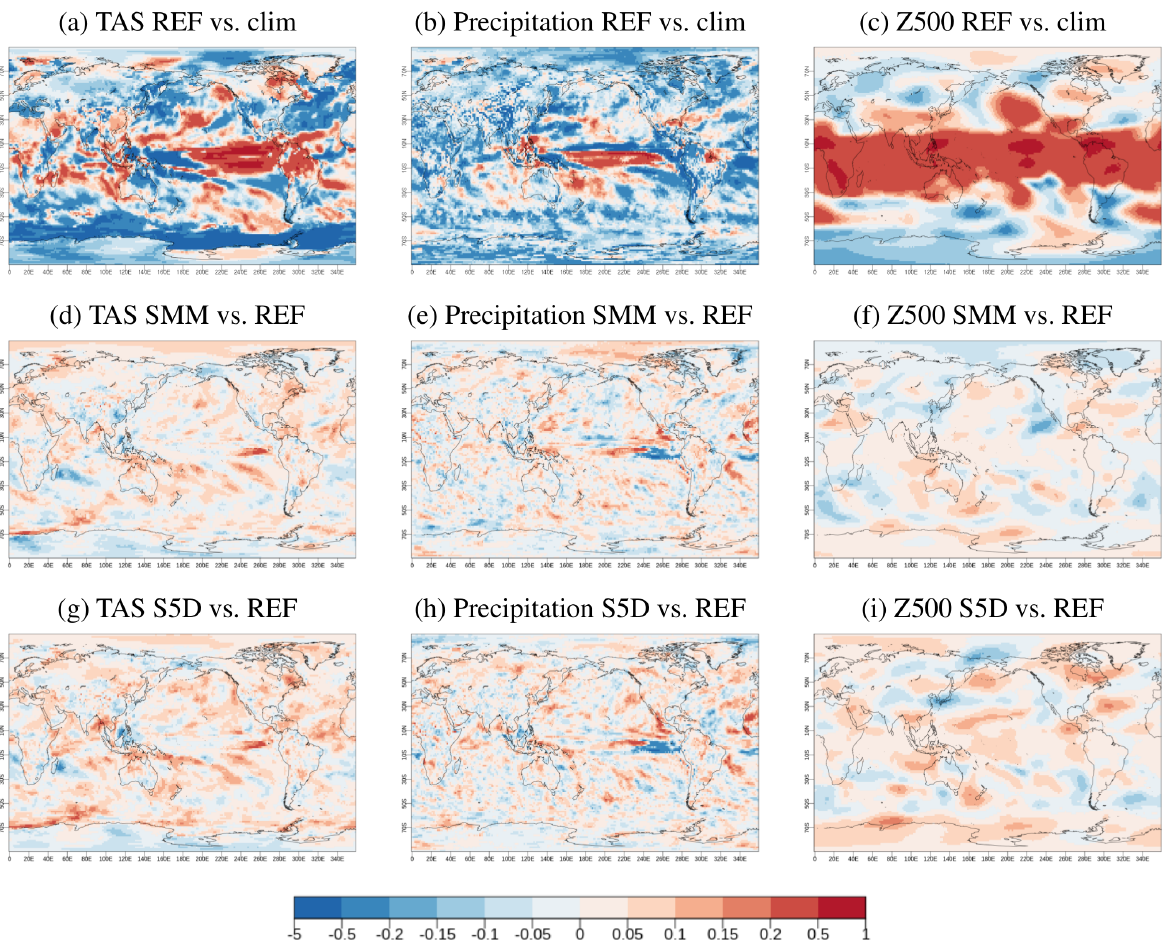
Figure 10. (a–c) DJF continuous ranked probability skill score (CRPSS) for the REF experiment near-surface air temperature, precipitation and Z500. Areas in red/blue indicate where the model skill is higher/lower than a reference forecast using climatology. (d–f, g–i) Same as (a–c) but for SMM and S5D experiments (middle and bottom rows, respectively) computing CRPSS with REF as a